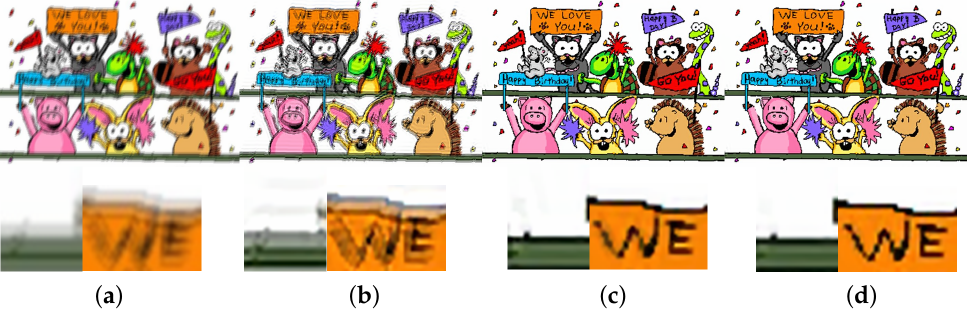
Figure 6. A comparison of our method with state-of-the-art methods. The images ( a – d ) are blurry input, result of Pan et al. [16], result of Yan et al. [19] and our result, respectively.